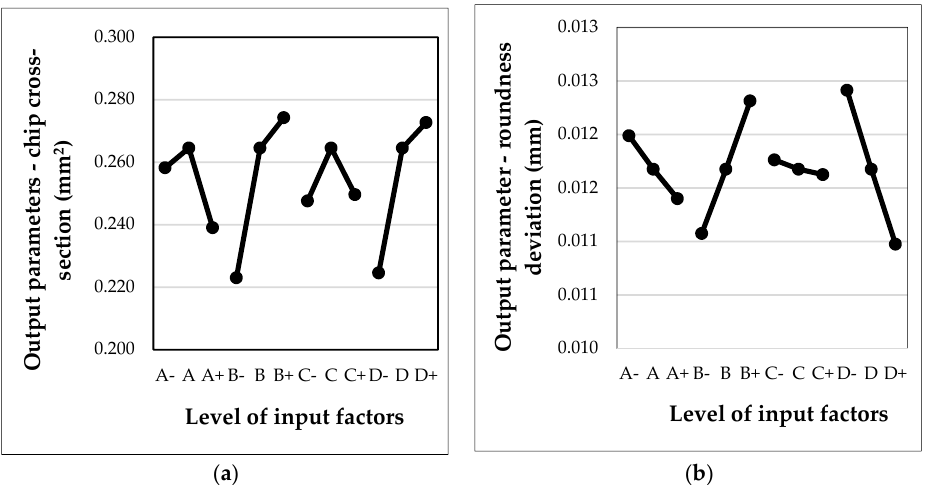
Figure 16. ( a ) Influence of rotation factors on multi ‐ characteristics; ( b ) The effect of input factors A, B, C and D on the values of roundness deviation.